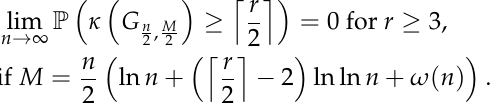
v 1 , v 2 v 3 , v 4 and in a graph of n = 4 v , v v , v and in a graph of n = 4 { } { } 1 2 } 3 4 } { {